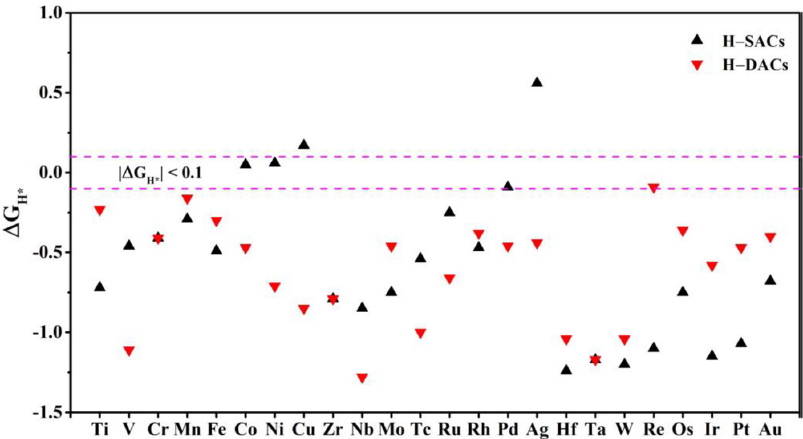
Figure 6. Gibbs free energy ( ∆𝐺 (cid:3009) ∗ ) for HER on the SACs is represented by the black triangle, corresponding ∆𝐺 (cid:3009) ∗ on the DACs is represented by the red triangle.